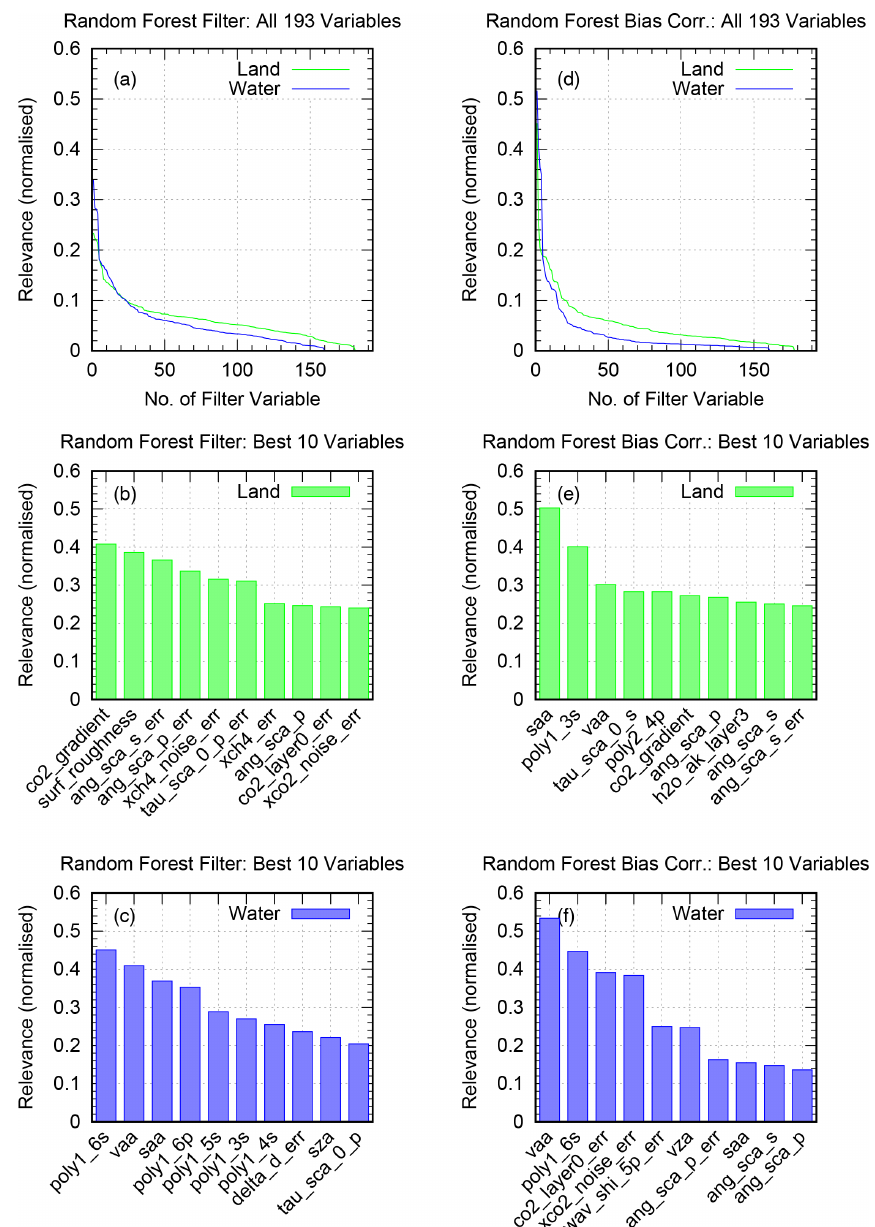
Figure 5. Random forest results for GOSAT. (a–c) Results from the random forest filter. (d–f) Results from random forest bias correction. (a, d) Normalised relevance (score) of all filter variables. (b, e, c, f) Selected variables and their relevance for the land and water